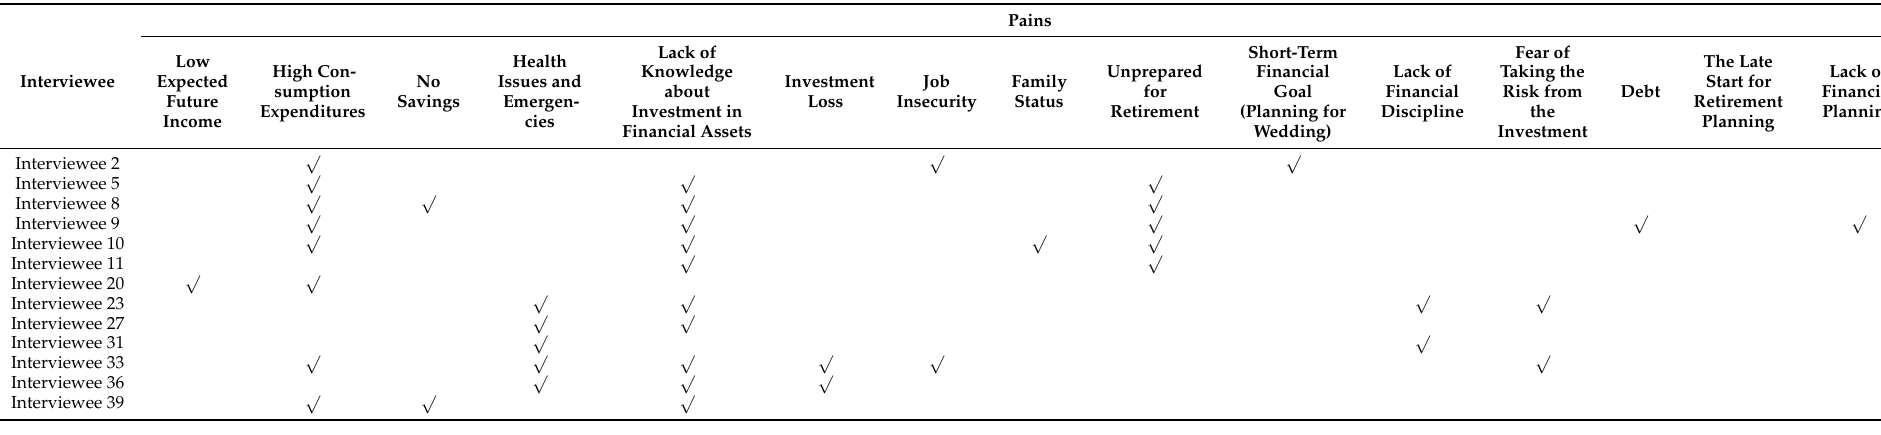
Table 6. Most common pains from interviewees of segment 3.